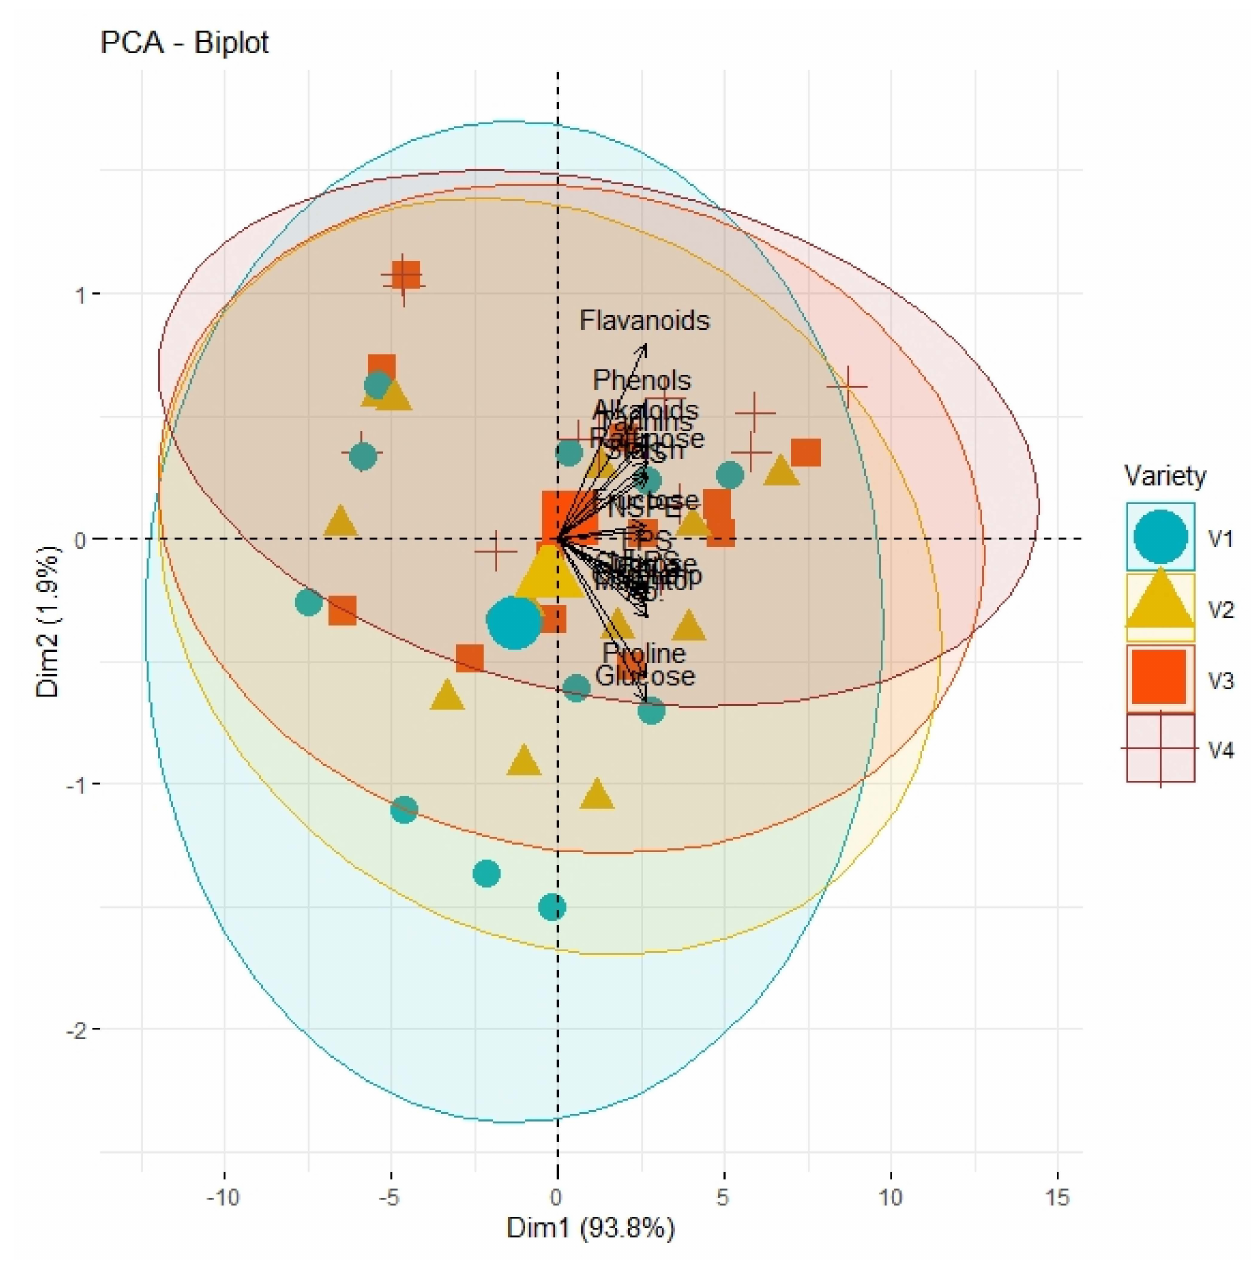
Figure 3. PCA graph explicating the varying extent of association and divergence of physiological, biochemical, and growth-related traits from origin with respect to type of genotypes (V1, Leccino; V2, Gemlik; V3, Moraiolo; V4,